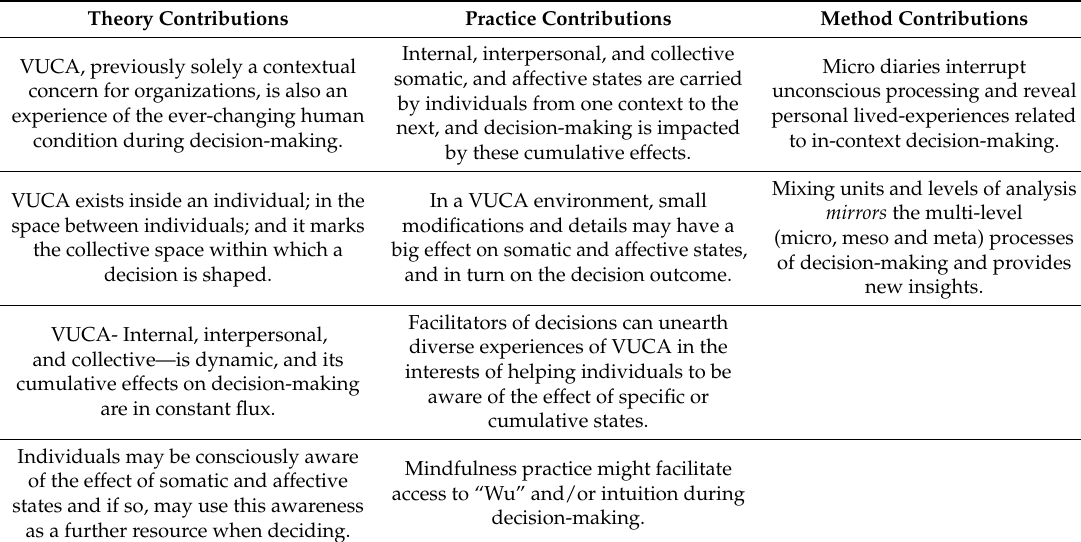
Table 6. Summary of